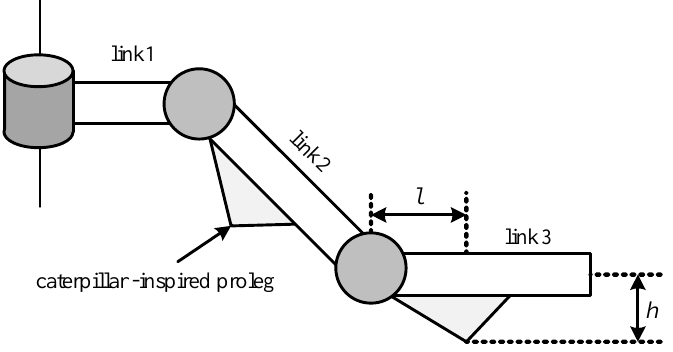
Figure 5. Leg structure of quadruped robot.